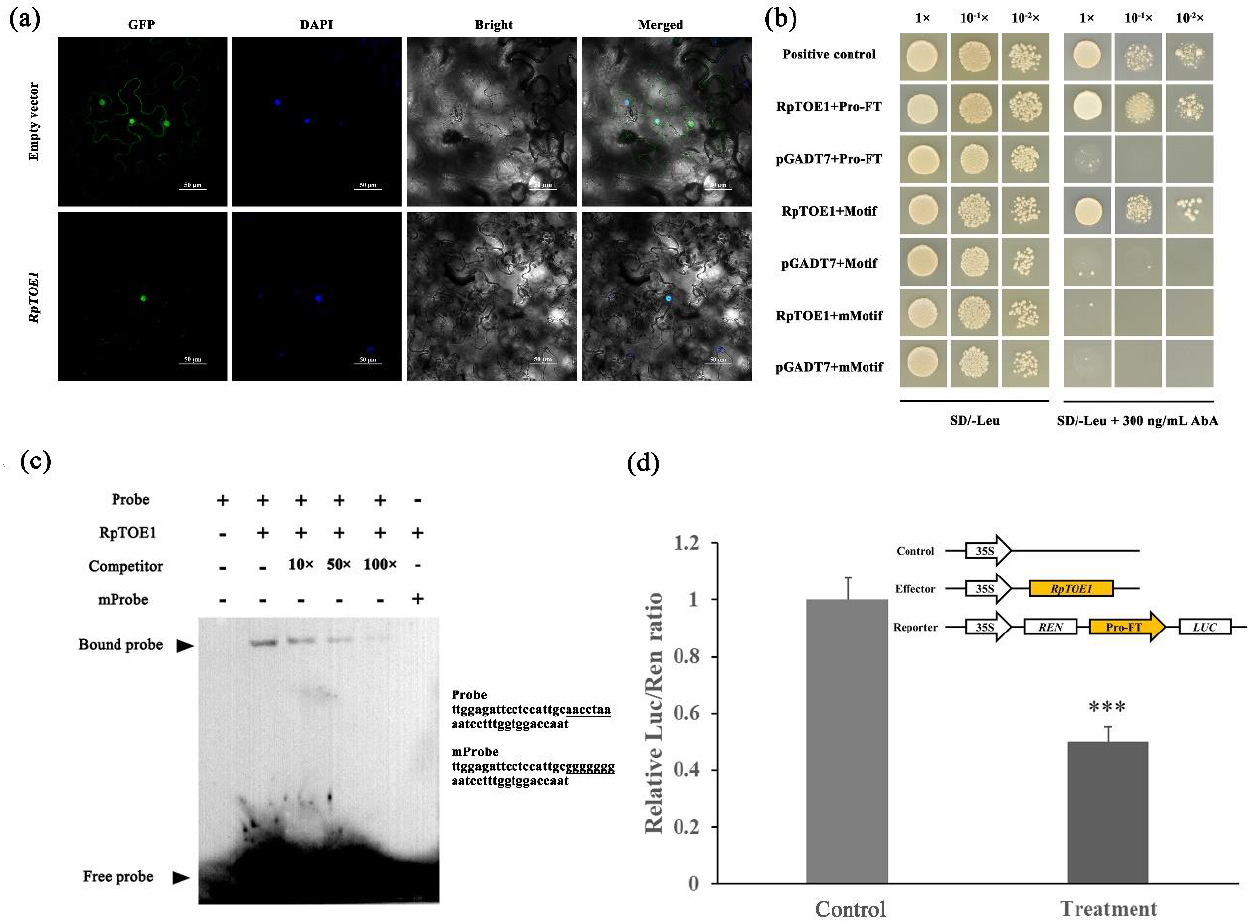
Figure 5. Transcription factor RpTOE1 directly repressed RpFT via a TBS-like motif. ( a ) Subcellular localization of RpTOE1, as determined by the expression of 35S: RpTOE1 -GFP constructs in tobacco leaves. The empty vector was used as the control. DAPI is a marker for localization in the nucleus ( n = 3). Bars, 50 µ m; ( b ) Yeast one-hybrid assays. Pro-FT indicates the ~2-kb promoter of RpFT . Motif indicates that the 300-bp sequence includes the TBS-like motif in the RpFT promoter. mMotif indicates the mutated form of the TBS-like motif. pGADT7-p53 and p53-pAbAi were constructed as positive controls ( n = 3); ( c ) Electrophoretic mobility shift assay. The probe sequence occurs in the RpFT promoter and harbors the TBS-like motif (Probe). The mutated probe (mProbe) was produced by replacing the TBS-like motif with ‘ggggggg’. ‘+’ and ‘-‘ indicate whether the reagents were present in the lane ( n = 3); ( d ) Dual-luciferase assay. Data showing the Luc/Ren ratios for co-expression of the empty effector control (Control) and for co-expression of the effector and reporter (Treatment) ( n = 6). Error bars represent SD. *** Significant differences from the control based on Student’s t -test ( p < 0.001).